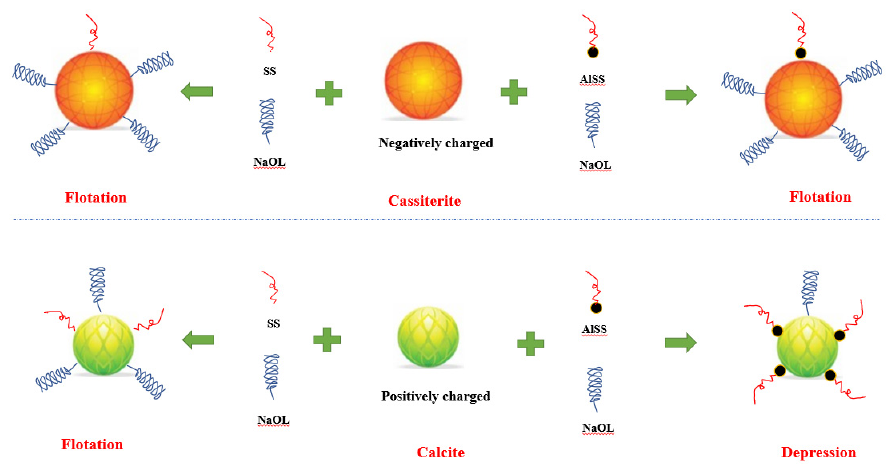
Figure 15. Schematic illustration of the selective flotation process.